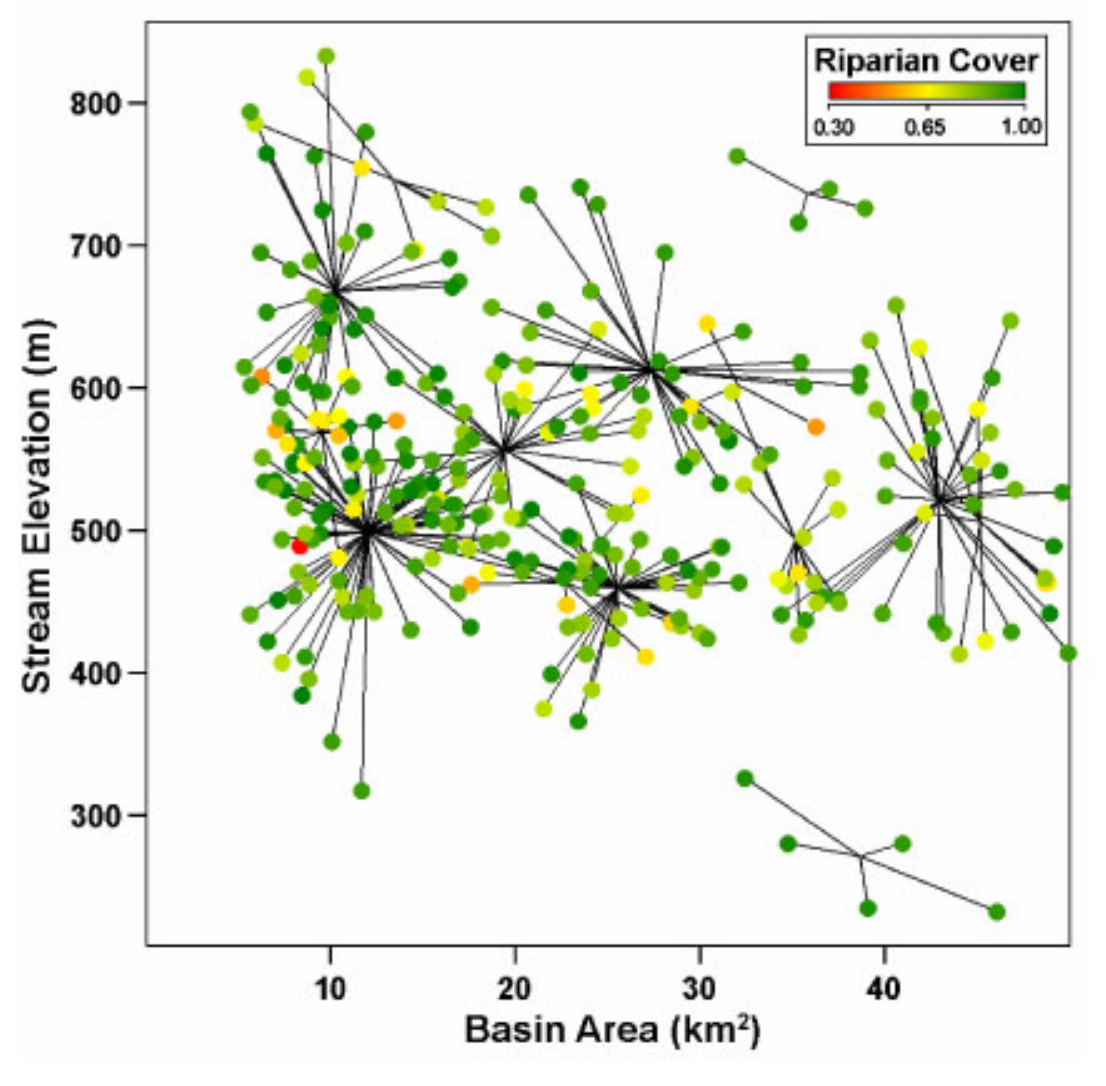
Fig. 5. Results from the cluster analysis used to select primary sampling sites. The dots represent individual stream segments. Each cluster has similar basin area, elevation, and percent riparian forest cover